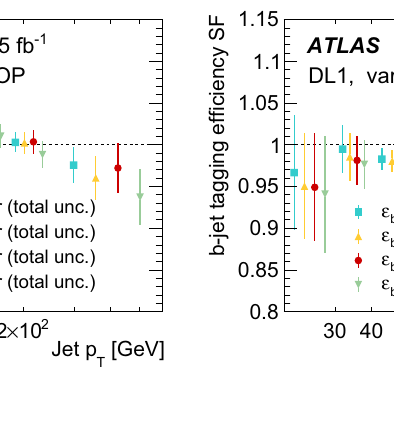
are offset for visual effects but computed in the same jet p T range. Vertical error bars represent the total uncertainty